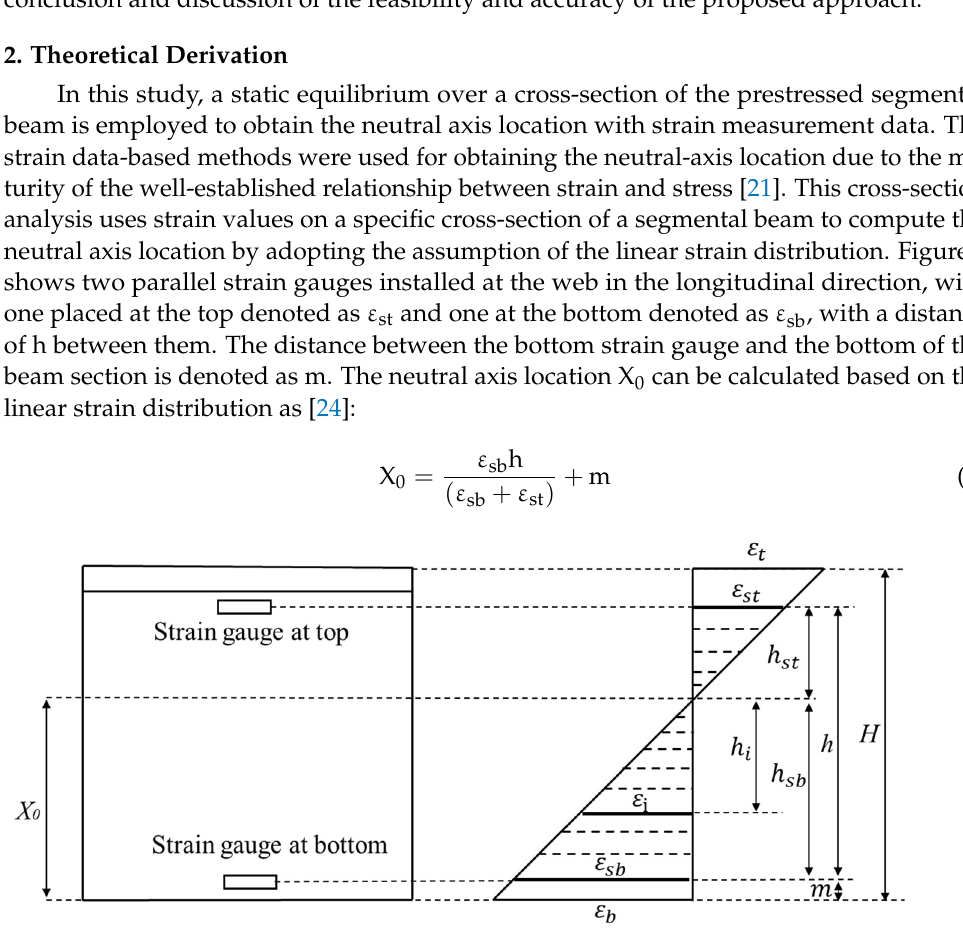
Figure 1. Strain distribution along the cross-section of the